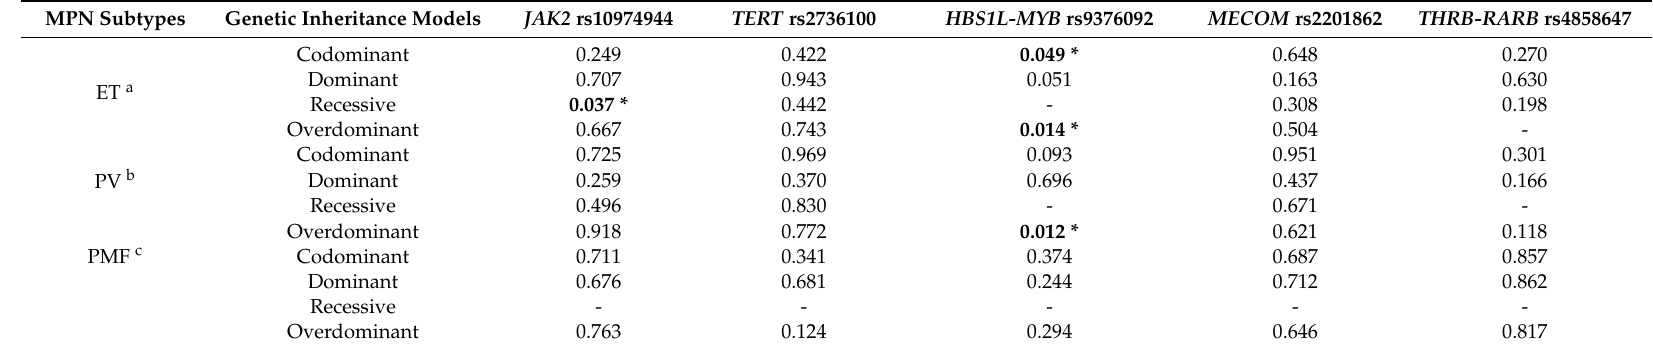
Table 6. The p -values for two-dimensional interaction between TET2 rs154843 SNP and other SNPs in MPN